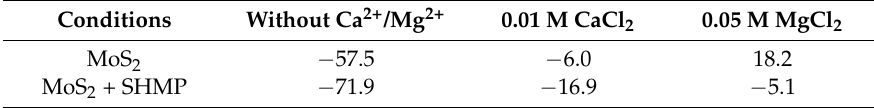
Table 2. Zeta potential of MoS 2 treated in various solutions at pH